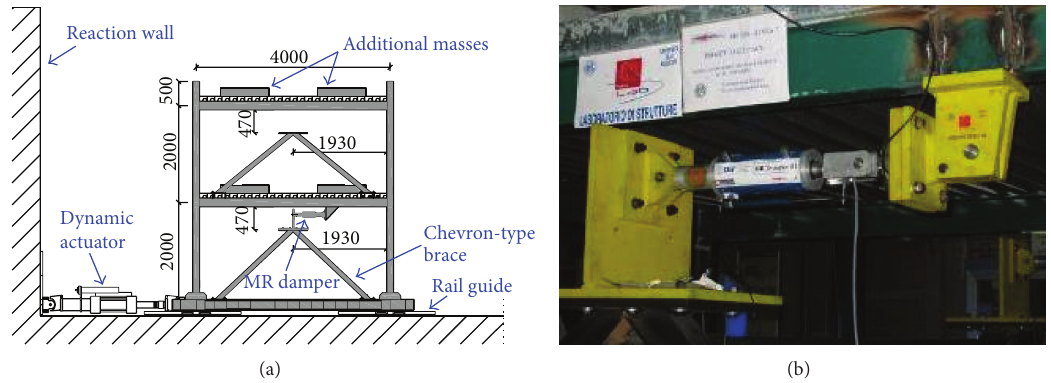
Figure 1: Lateral view of the mock-up structure (a). One of the two MR dampers installed at the first floor